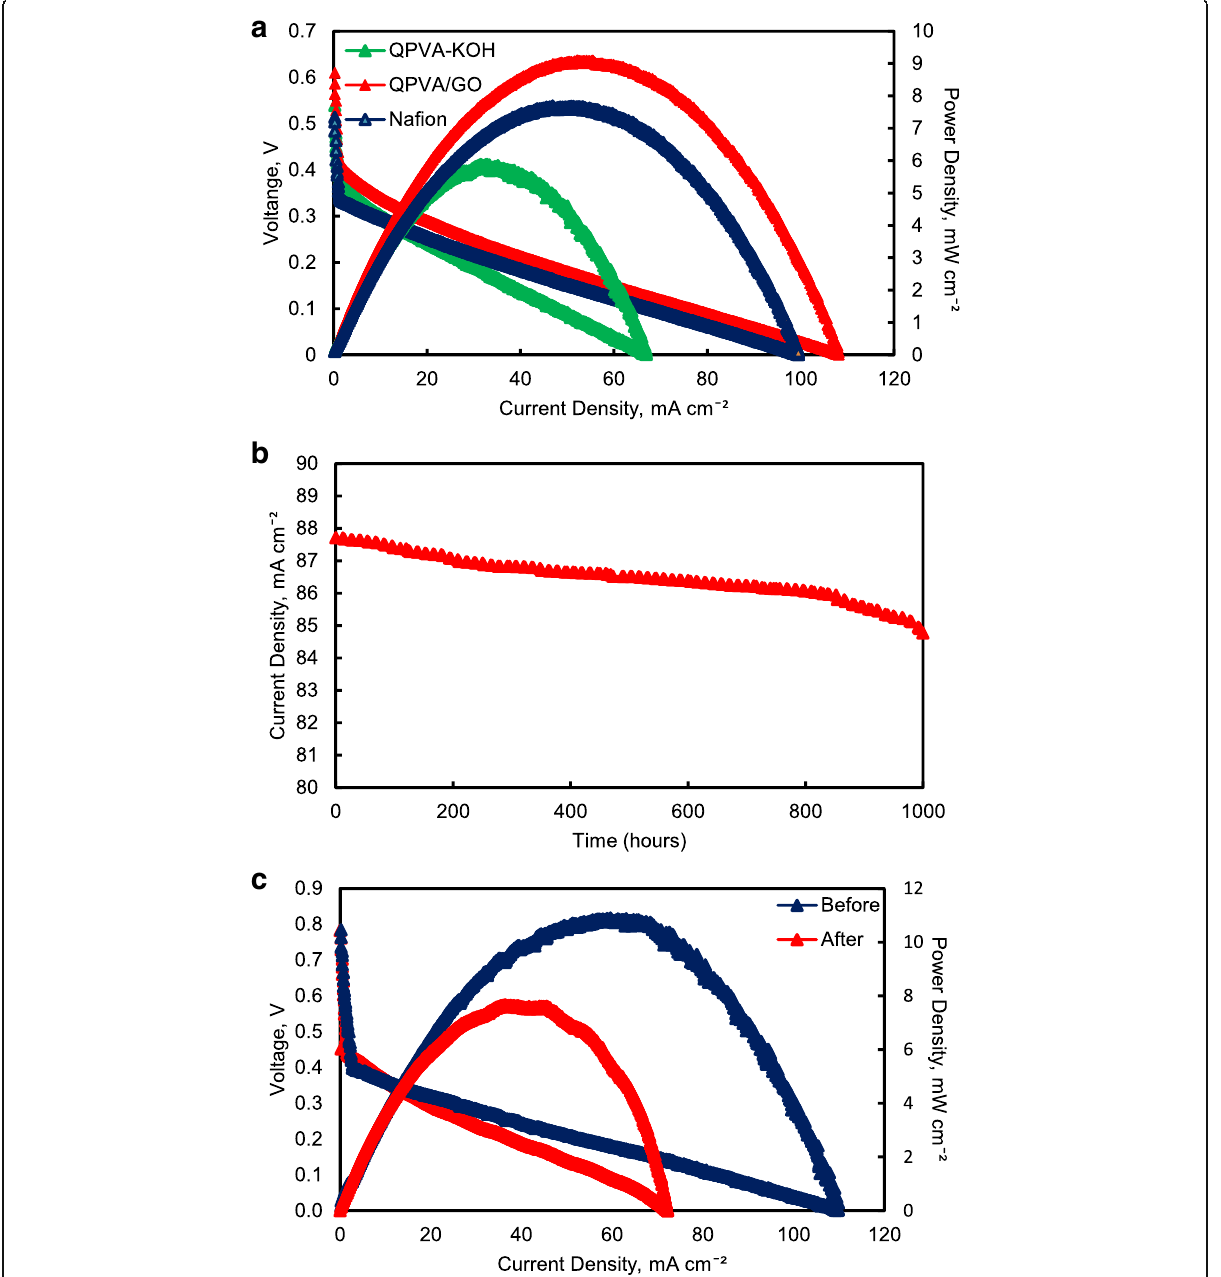
Fig. 17 a Cell voltage and power density vs. current density curve obtained for the passive alkaline – DEFC. b Durability test on passive alkaline – DEFC. c Cell voltage and power density vs. current density curve before and after 10,000 min of durability test. Anode feed; 2 M KOH + 2 M ethanol, vathode feed; Air: a at 30 °C; b , c at 60